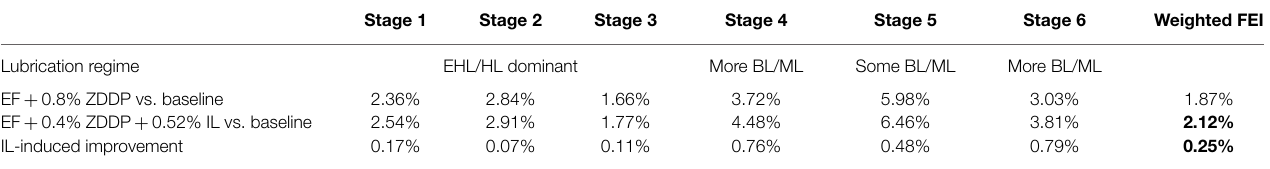
TABLE 7 | Sequence VIE fuel economy engine test results